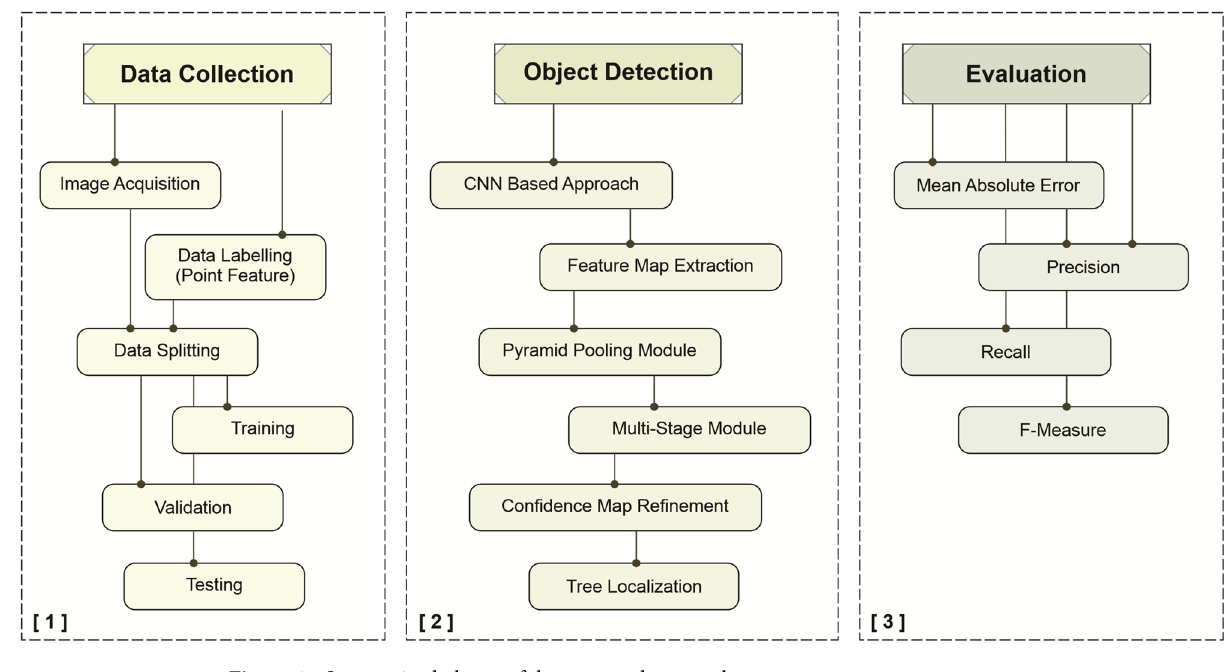
Figure 4. Summarized phases of the proposed approach.